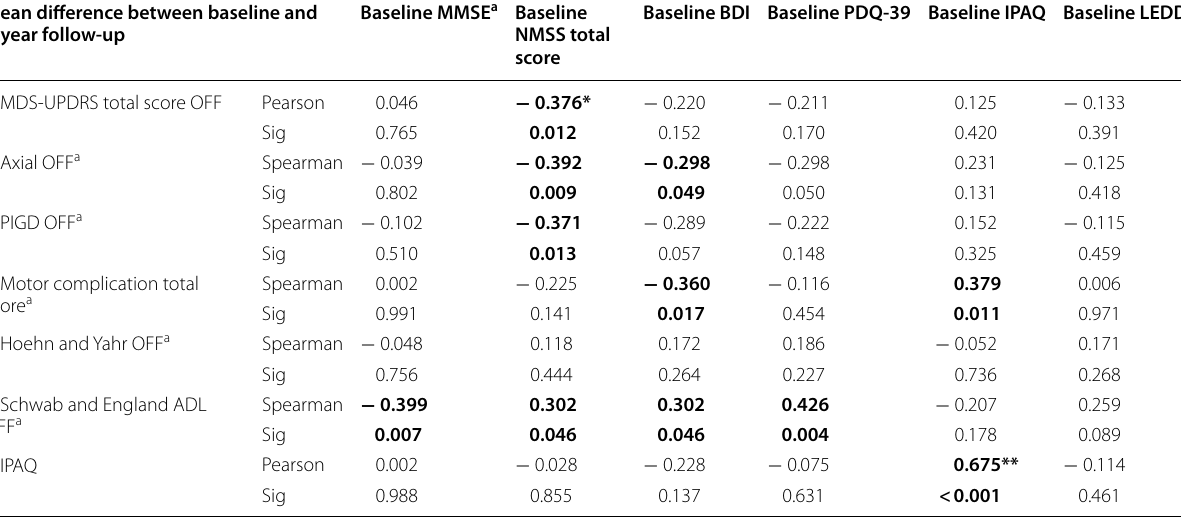
Bold values are